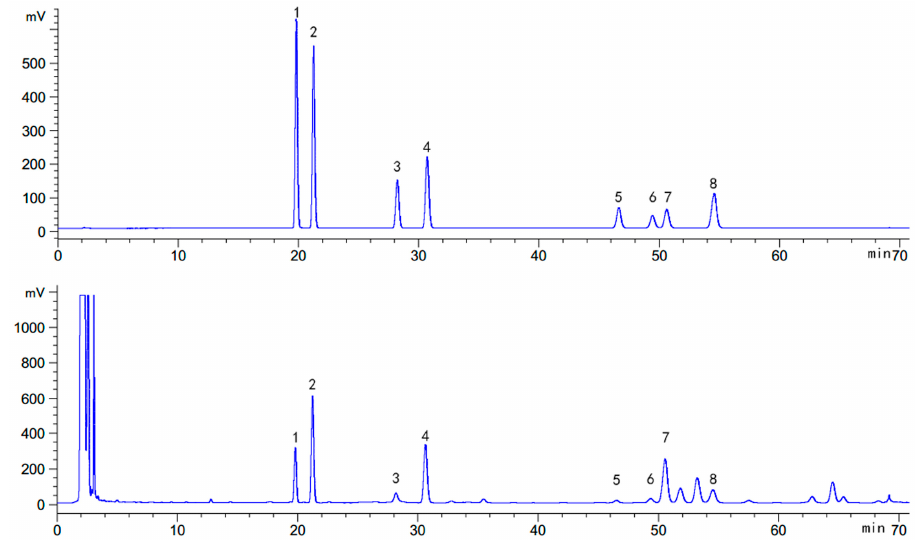
Figure 1. Peaks identification: ( 1 ) Deapioplatycoside E; ( 2 ) Platycoside E; ( 3 ) Deapioplatycodin D 3 ; ( 4 ) Platycodin D 3 ; ( 5 ) Deapioplatycodin D; ( 6 ) Platycodin D 2 ; ( 7 ) Platycodin D; ( 8 ) Polygalacin D.